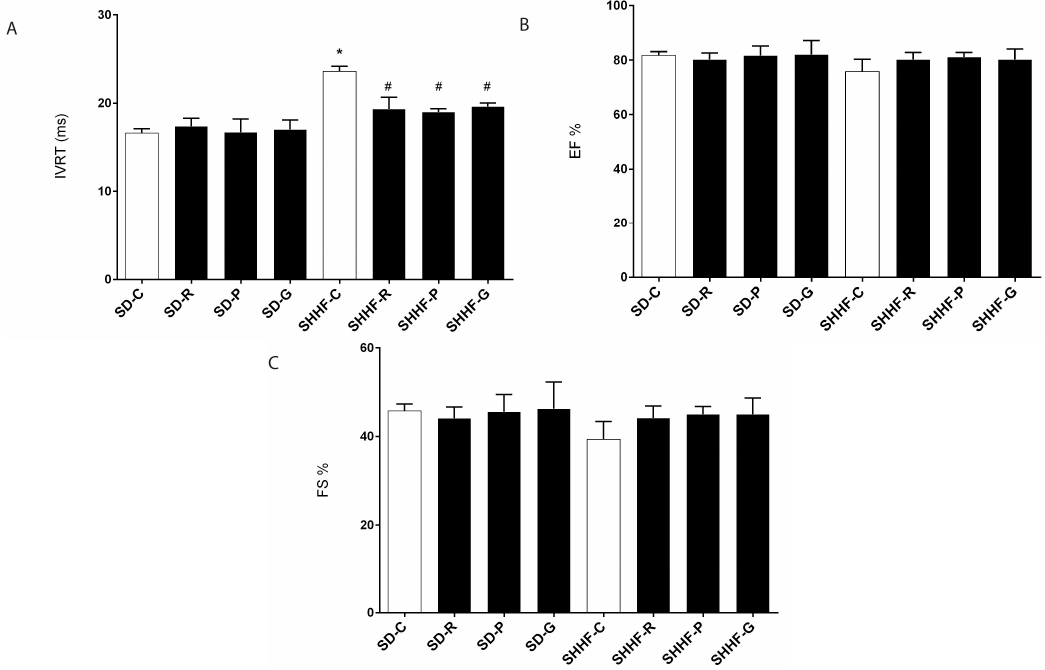
Figure 7. Stilbenoid treatment improves diastolic function in the SHHF rat. Compared to hearts from untreated SD rats (SD-C), ( A ) IVRT was impaired (i.e., prolonged) in SHHF rats, whereas parameters of systolic function such as ( B ) ejection fraction (EF) and ( C ) fractional shortening remained normal. 8-week treatment with resveratrol (R; 2.5 mg/kg/day), pterostilbene (P; 2.5 mg/kg/day), or gnetol (G; 2.5 mg/kg/day) improved IVRT. n = 6–8. * p < 0.05 vs. SD-C hearts; ; # p < 0.05 vs. SHHF-C. Table 1. Effect of stilbenoid polyphenols on blood pressure.